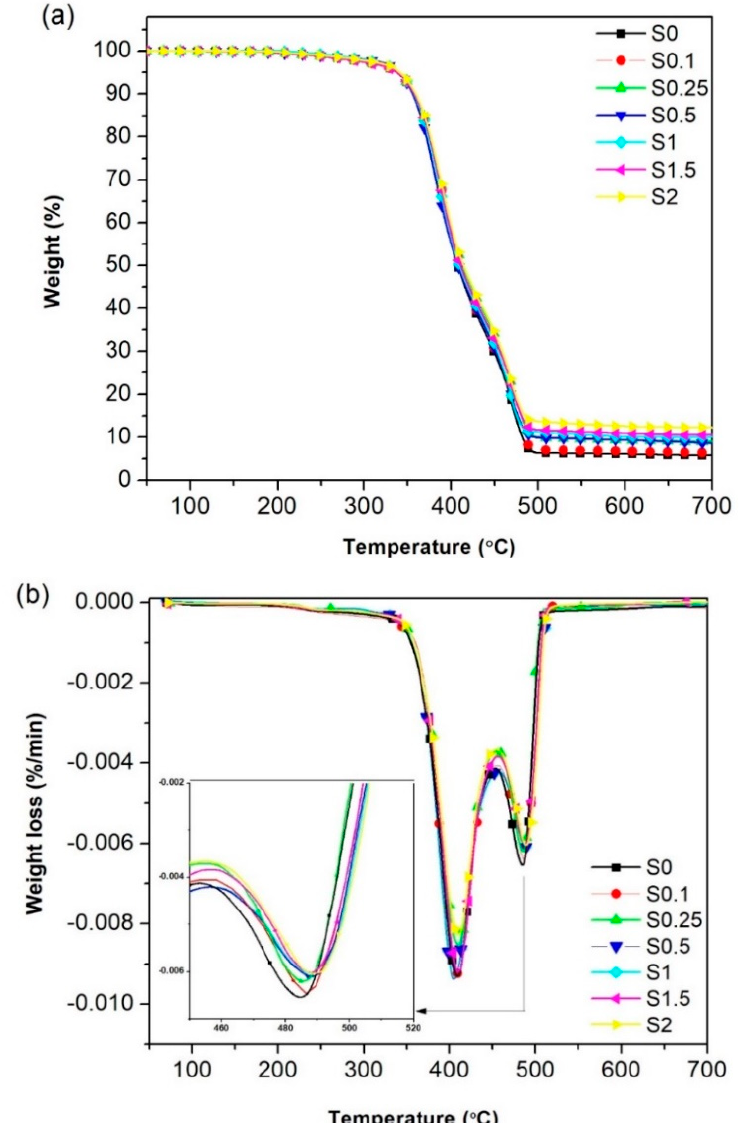
Figure 8. Thermal degradation behavior of the NR/CNT/GNS foams with different hybrid nanofiller content: ( a ) TGA curve and ( b ) DTG curve.